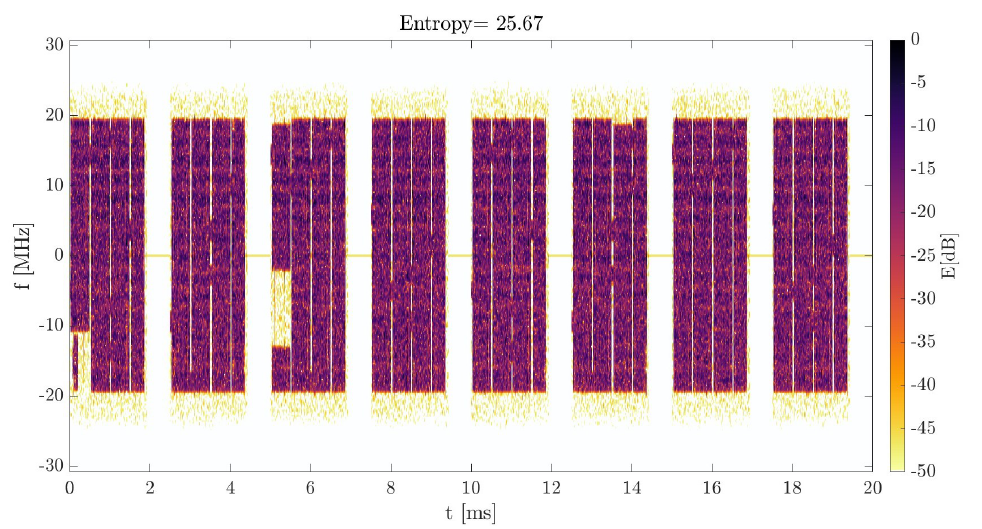
Figure 20. Spectrogram of the reference signal with maximum resource